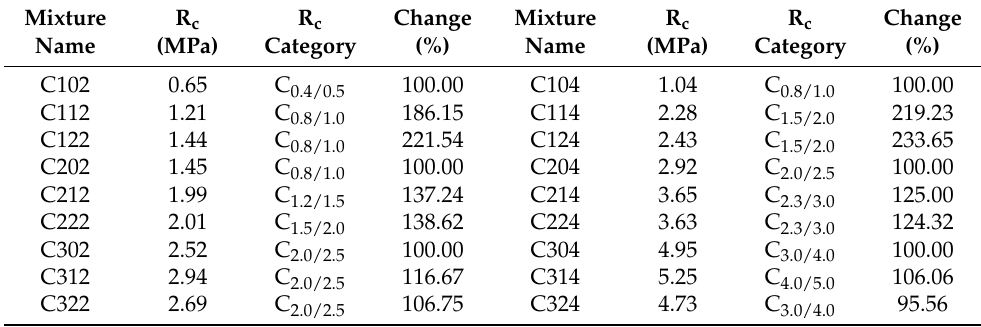
Table 6. Summary of unconfined compression strength results.